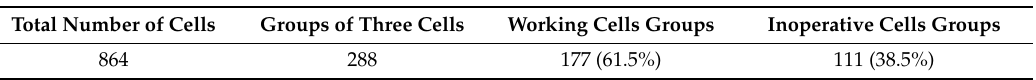
Table 3. Real condition of the cells, considering the bypass diodes, before dehumidifying the